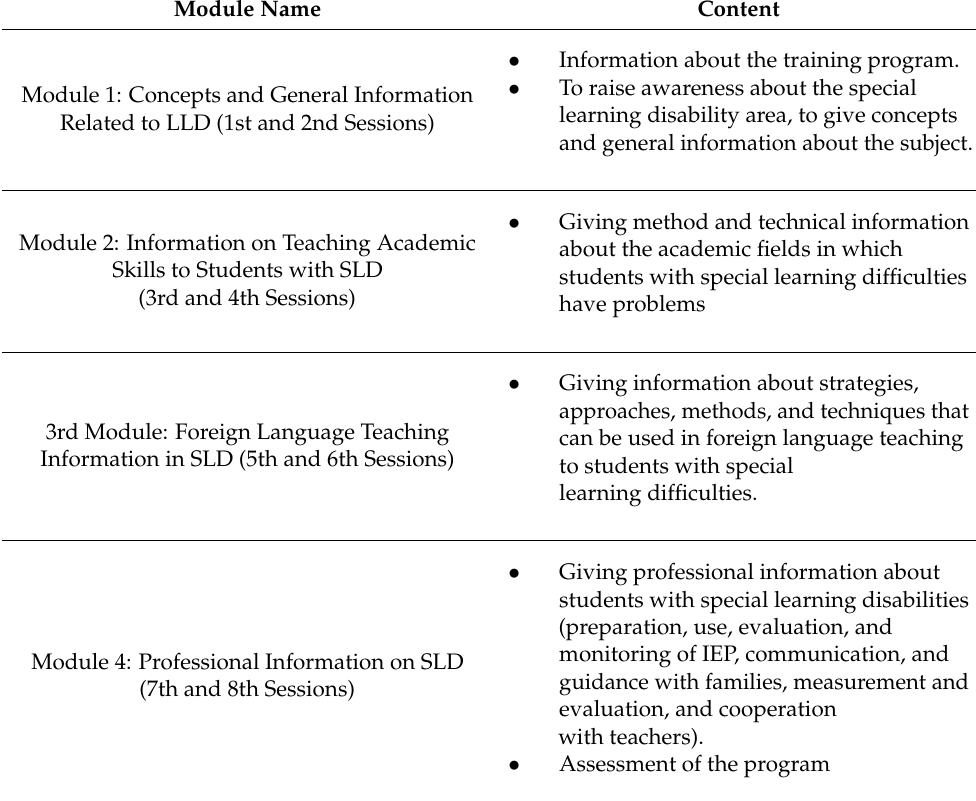
Table 3. The content of the SLD teacher education